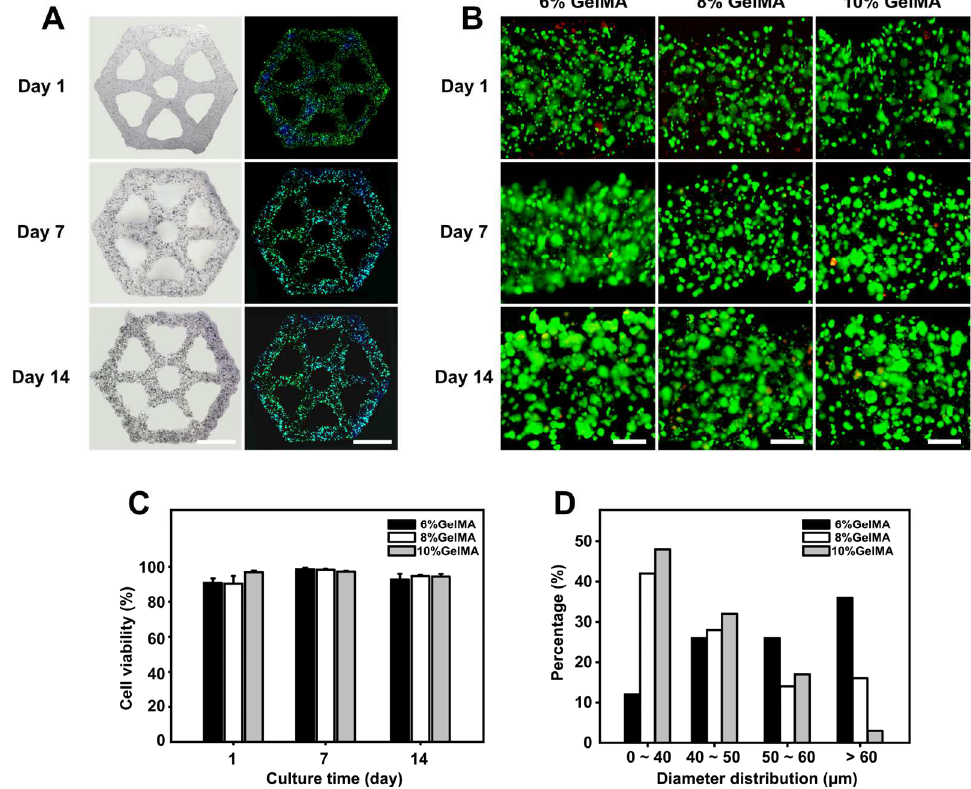
Figure 3. Liver lobule-like constructs fabrication and culture. ( A ) Bright-field and F-actin fluores- cent images showing liver lobule-like constructs at days 1, 7, and 14. Scale bar: 2 mm. ( B ) Live/dead analysis of liver lobule-like constructs printed with different GelMA concentrations during 14 days of culturing. Scale bar: 200 µm. ( C ) Cell viability calculation at days 1, 7, and 14. ( D ) Cell diameter distributions in the liver lobule-like constructs with different GelMA concentrations after 14 days of cultivation.